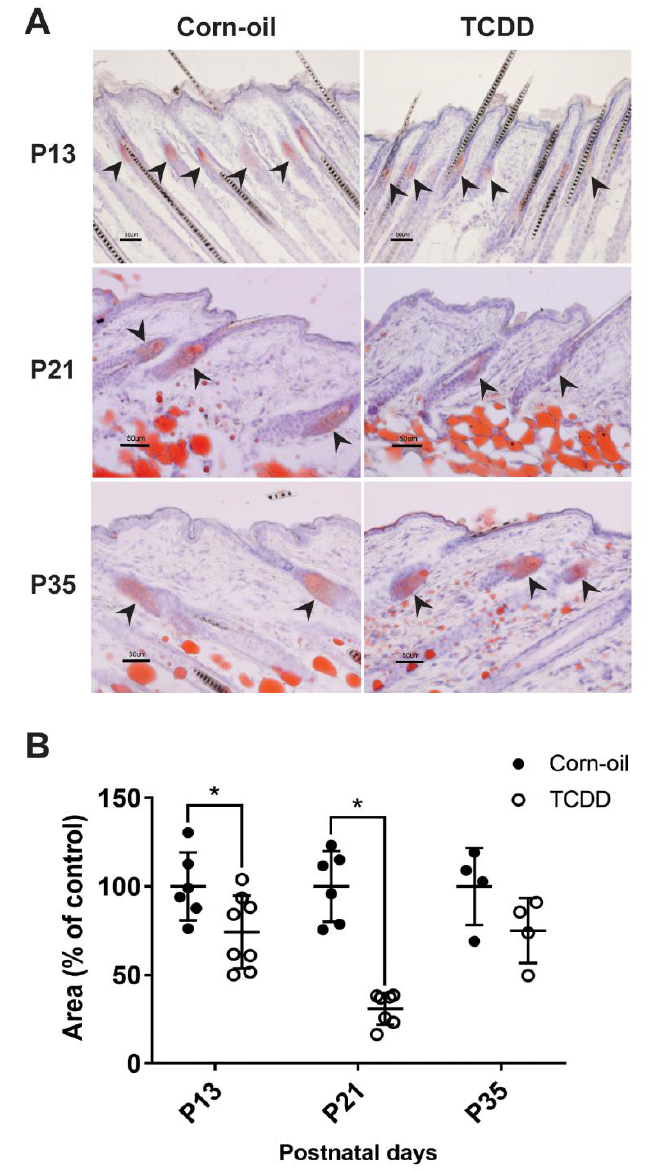
Figure 6. Sebaceous gland morphology and lipid storage. Time-mated mice were treated by gavage with either corn-oil or TCDD (5 µ g/kg bw) and pups were analyzed for effects on sebaceous glands. ( A ) Representative images of Oil Red O staining of corn-oil- and TCDD-treated frozen skin sections at P13, 21, and 35. Scalebar = 50 µm. Arrowheads point towards sebaceous glands stained with Oil Red O. ( B ) The quantitation of the area of Oil Red O-stained sebaceous gland is expressed as a percentage of control. The graph displays the mean values ± SDs. Each symbol represents an individual animal ( n = 4–8). Data were analyzed by a two-tailed Student’s t -test. * p < 0.05, compared to age-matched corn-oil control. Abbreviations: TCDD, 2,3,7,8-tetrachlorodibenzo- p -dioxin; bw, body weight; P, postnatal day.